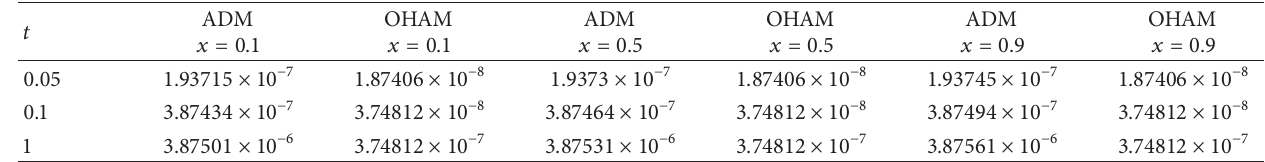
Table 1: Comparison of absolute errors of OHAM and ADM [5] for 𝛼 = 1 , 𝛽 = 1 , 𝛿 = 1 , and 𝛾 = 0.001 . OHAM ADM 𝑡 ADM 𝑥 = 0.1 𝑥 = 0.1 𝑥 = 0.5